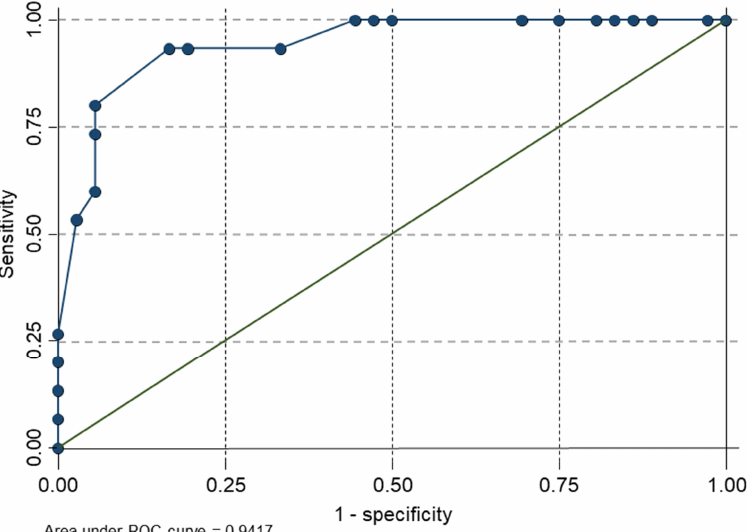
Figure 1. Graph of sensitivity versus 1 minus the specificity of the final predictive model.